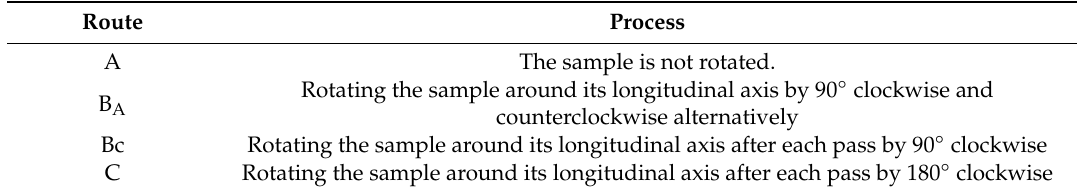
Table 1. Four basic routes that can be applied in a ECAP